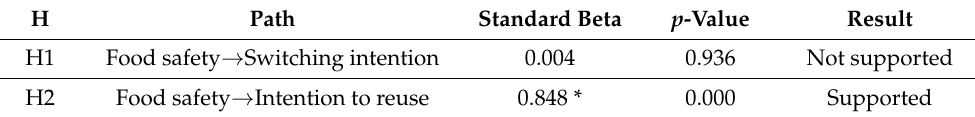
Table 5. Hypothesis